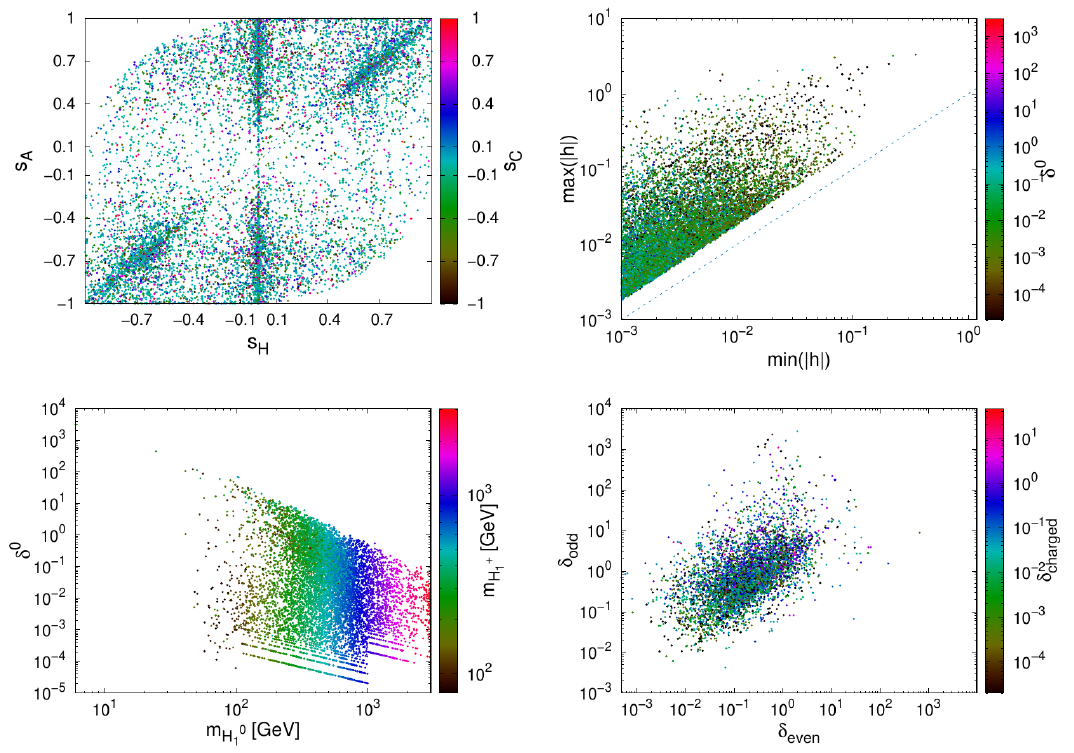
Figure 2 . Left-top: the CP-even mixing angle sine vs the corresponding CP-odd one, where the palette shows the mixing of the charged scalar sector. Right-top: the strength of the new Yukawa couplings h where the palette shows the ratio δ 0 = ( m 2 ) /m 2 . Left-bottom: the − m 2 αi A 0 1 H 0 1 H 0 1 mass ratio δ 0 = ( m 2 ) /m 2 versus the light CP-even scalar mass m 2 , where the palette − m 2 A 0 1 H 0 1 H 0 1 H 0 1 shows the light charged scalar mass m 2 . Right-bottom: the ratios δ = ( m 2 ) /m 2 , − m 2 even H 0 2 H 0 1 H 0 1 H ± 1 ) /m 2 and δ = ( m 2 ) /m 2 that represent the mass relative δ even = ( m 2 − m 2 − m 2 charged A 0 2 A 0 1 A 0 1 H ± 2 H ± 1 H ± 1 difference in each sector.